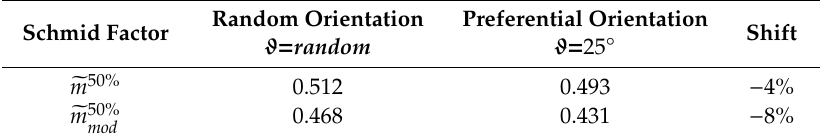
Table 4. Comparison of the median values of the Schmid factor distributions f SF ( (cid:101) m ) (geometric approach) and f SF ( (cid:101) m mod ) (from FEA).